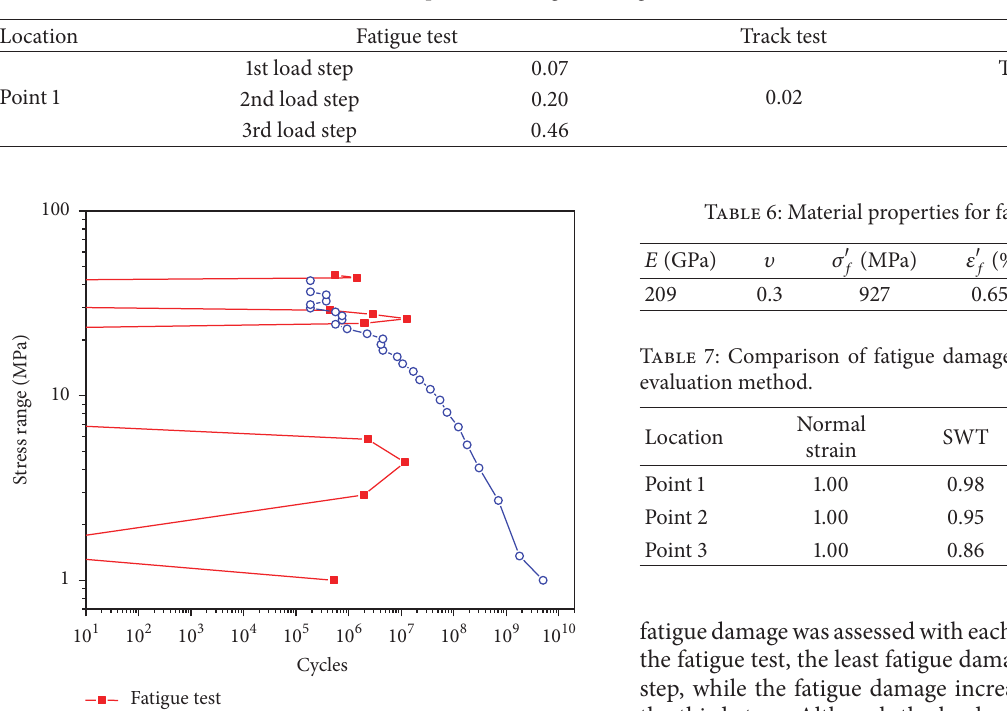
Table 5: Comparison of fatigue damage between lab test and track test.